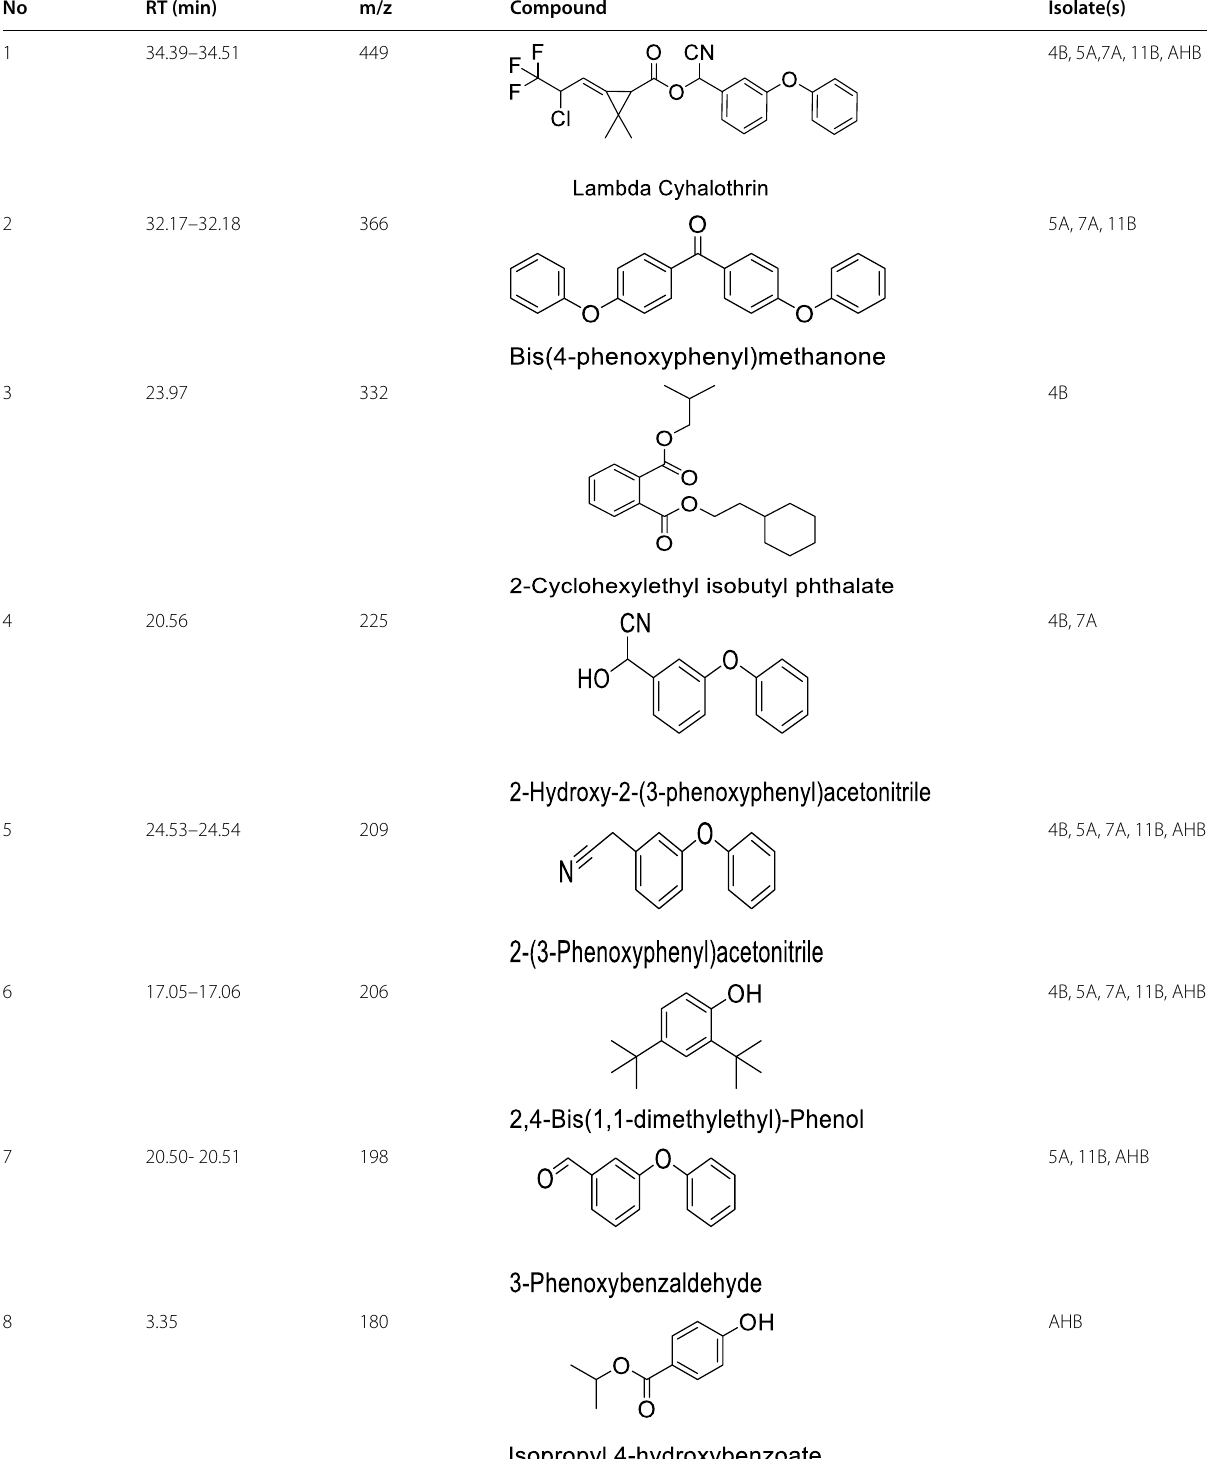
Table 3 A summary of the metabolites detected by GC/MS during the biodegradation of λ-cyhalothrin by the bacterial isolates after 24